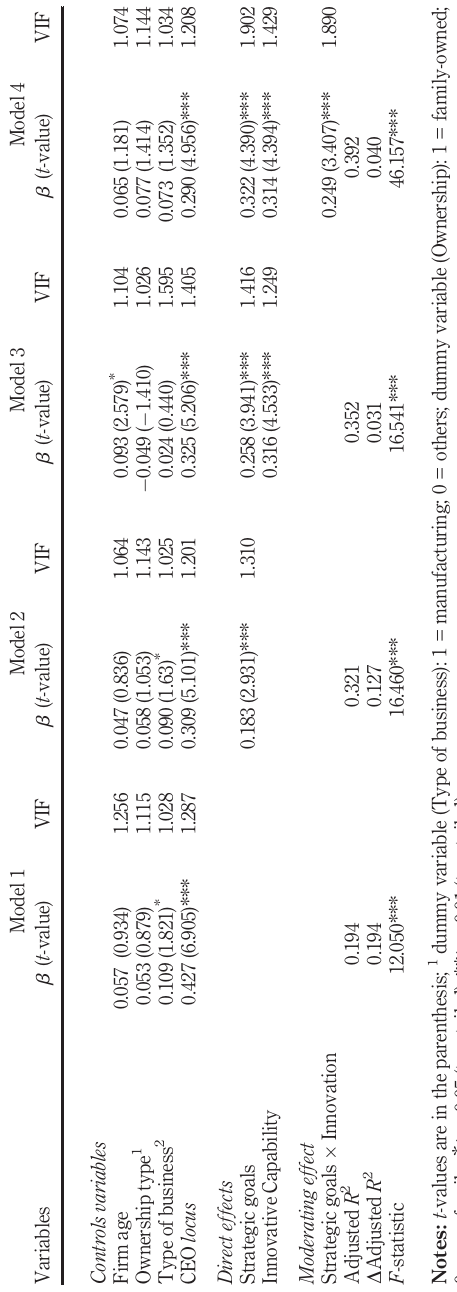
Table V. Standardized regression